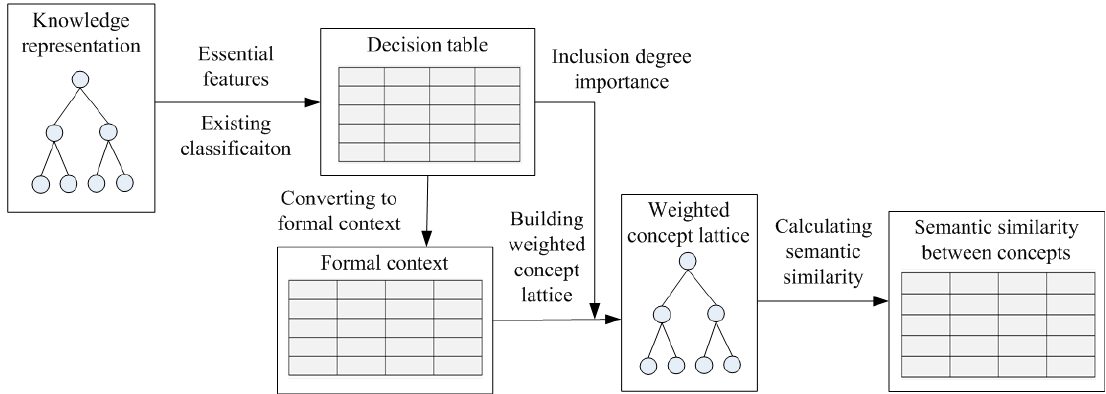
Figure 1. Workflow for semantic similarity measurement based on a weighted concept lattice (SSMWCL).